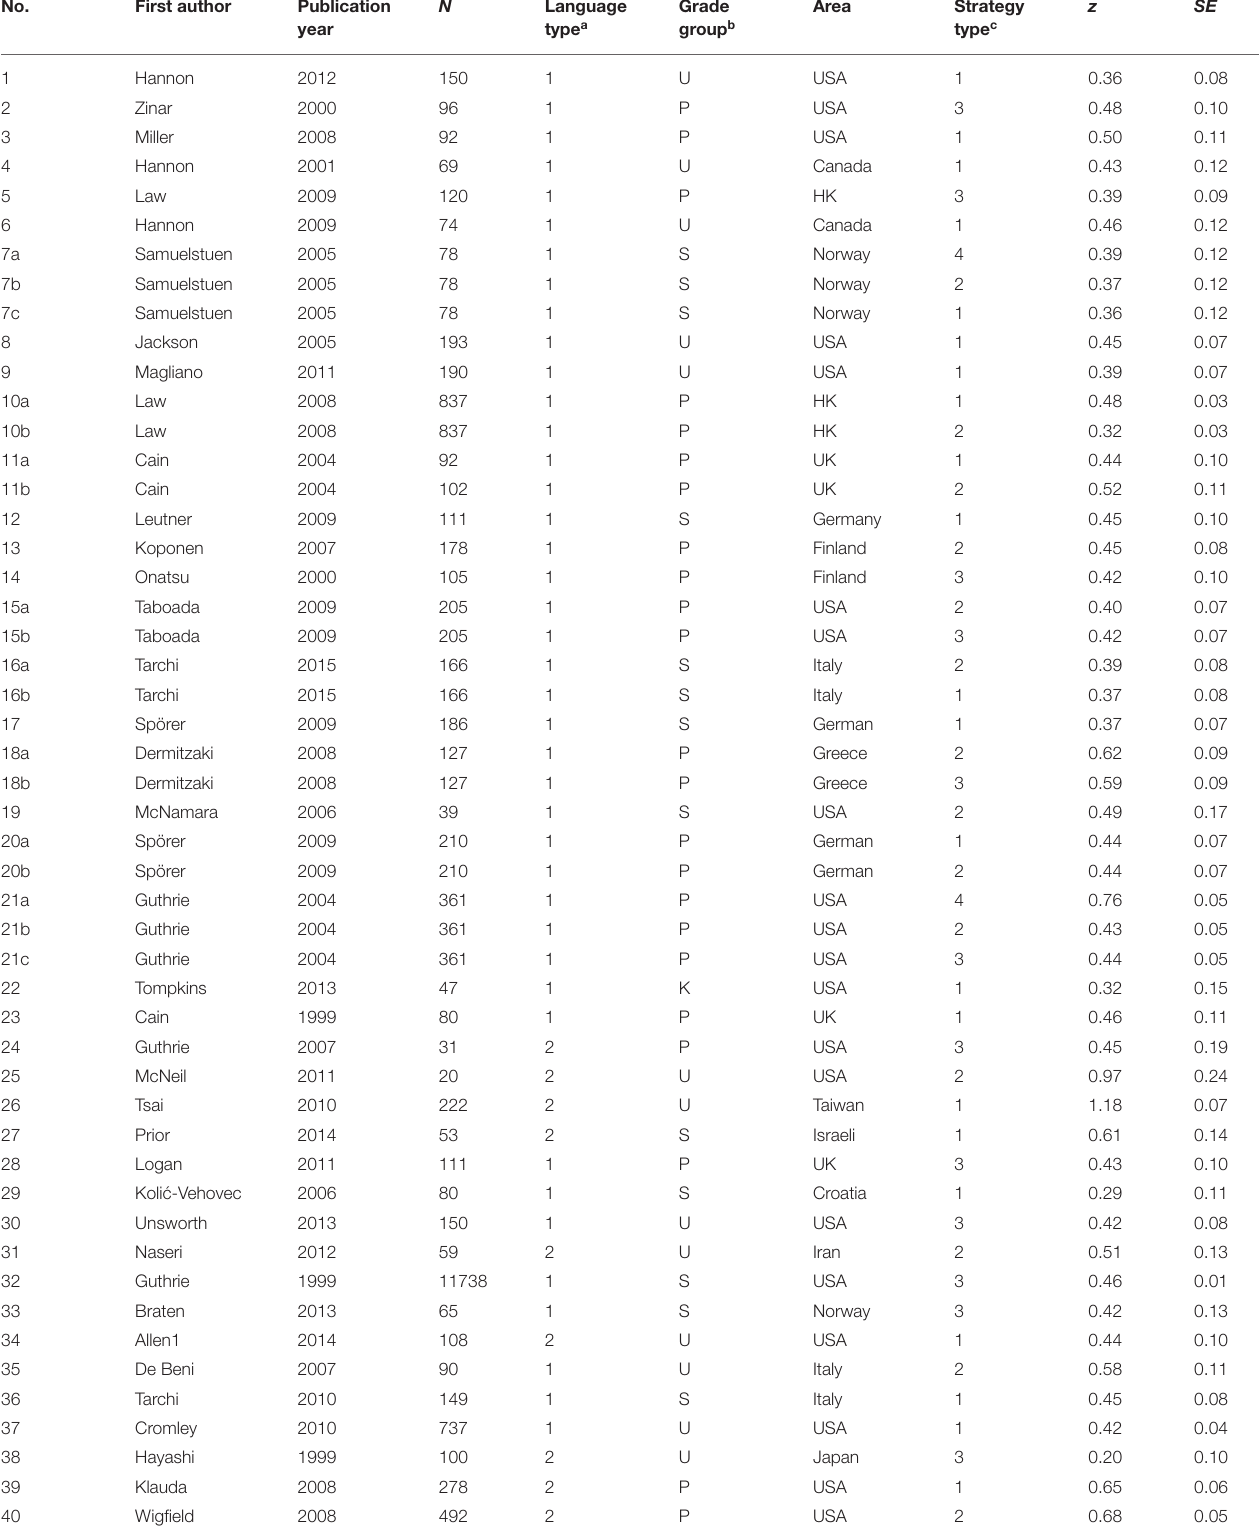
TABLE 1 | Description and outcomes in